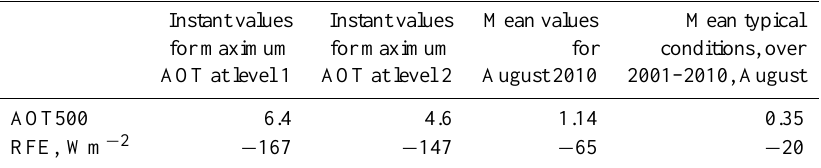
Table 3. Instant and climatological aerosol radiative forcing effects (RFE) at the TOA. Summer conditions. Calculations were made using the regression dependences (3) and (4) (see the text and Fig.